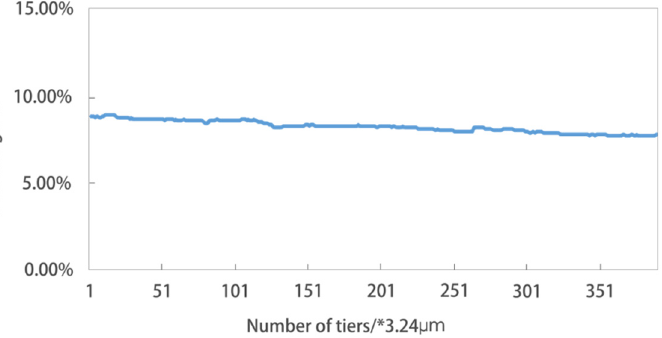
Figure 25. Diagram of volume proportion change in the hexagonal core along the direction of sample thickness.